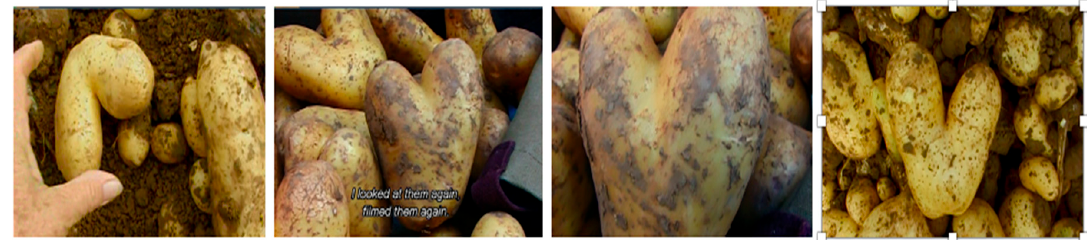
Figure 7. A sample of the heart-shaped potatoes to which Varda returns almost obsessively.